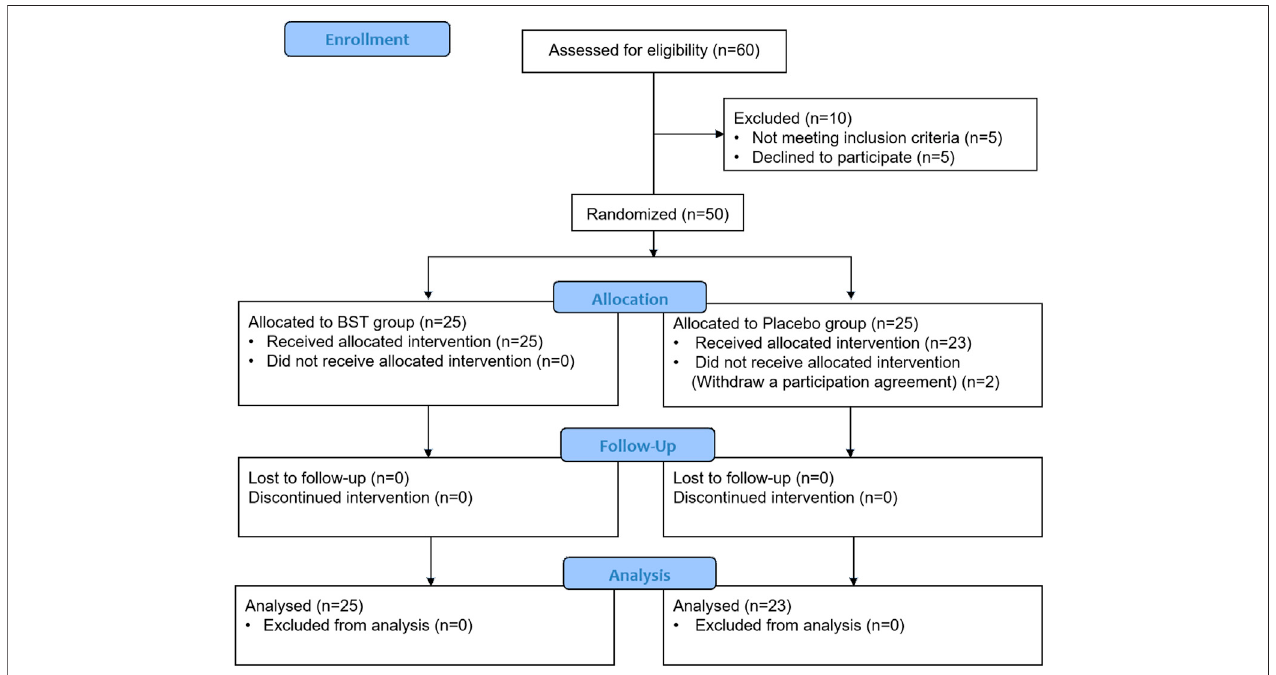
FIGURE 1 | Flow diagram of subject progress through the phase of the